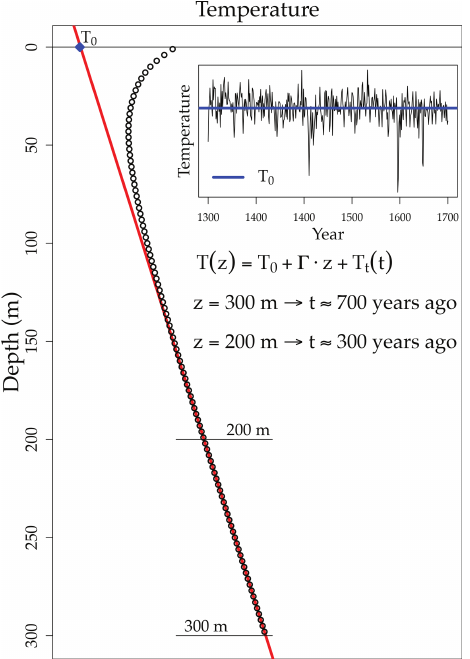
Figure 1. Synthetic borehole temperature profile (black dots) us- ing data from the CCSM4 PM simulation (inset) and the linear fit of temperatures between 200 and 300m (red line). The synthetic temperature profile is generated using the simulated global ground temperature anomaly at a depth of 1.0m for the period from 1300 to 1700CE as the transient perturbation ( T t ), mean ground tempera- ture as the long-term surface temperature ( T 0 ) and a typical thermal gradient ( (cid:48) ) of 0.01Km − 1 (Jaume-Santero et al., 2016). The equiv- alence between depth ( z ) and time ( t ) is given by Eq. (3). Thermal diffusivity is considered as κ = 1 × 10 − 6 m 2 s − 1 (Cermak and Ry- bach,